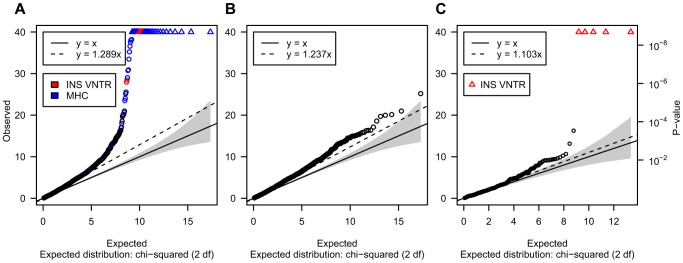
Quantile-quantile plot comparing the expected versus the observed distribution of the FBAT-CNV P-values.These plots show the distribution of -2log10(p), which is, under the null, distributed as chi-square with 2 degrees-of-freedom. IgG/TCR loci are discussed elsewhere and not included in these plots. A – N = 3,286 CNVs that passed quality controls and were tested for association. Loci overlapping the MHC region are marked in blue. Loci mapping to, or in strong LD with, the INS VNTR region are marked in red. B – N = 3,214 CNVs passed quality controls and did not overlap or tagged the INS VNTR and the MHC region. C – N = 448 VNTRs targeted by the CGH array that passed quality controls. INS VNTR CNV regions are marked in red as in Figure 3A.